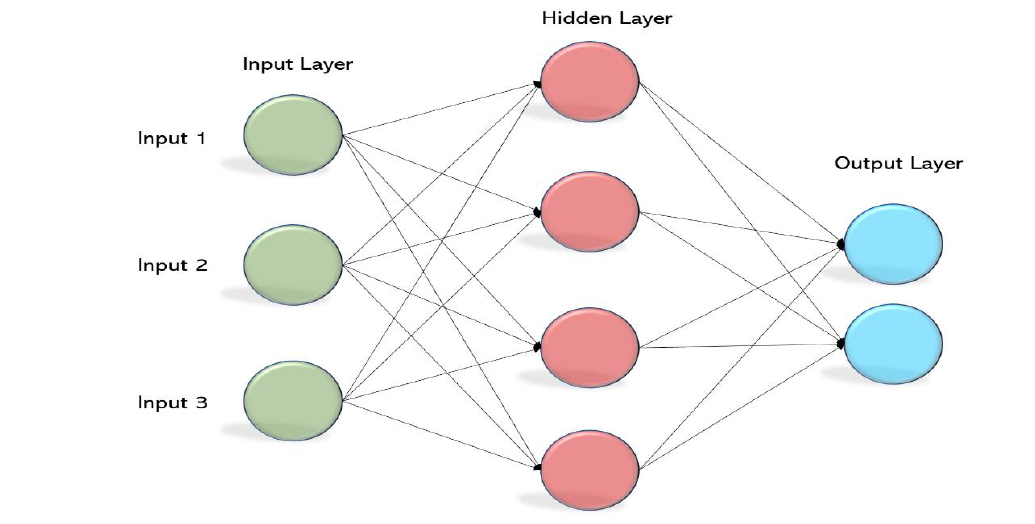
Figure 4. Structure of a multi-layer artificial neural network.